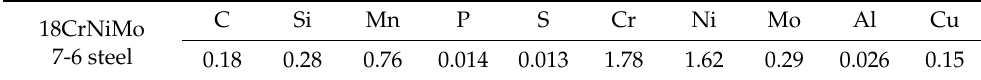
Table 1. Chemical composition of the tested steel (%